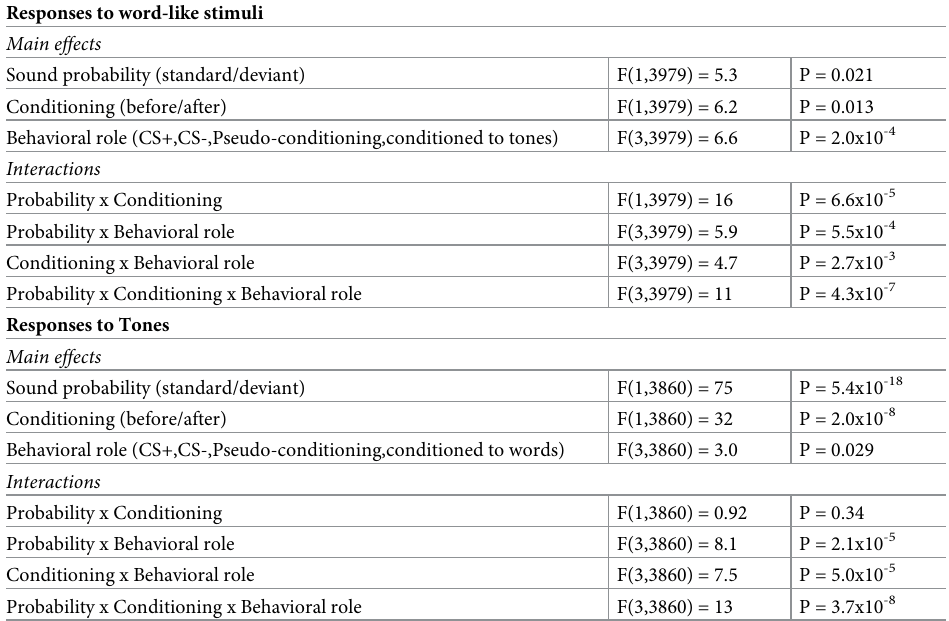
Table 1. Results for all fixed effects of the two models (Matlab routines fitlme and